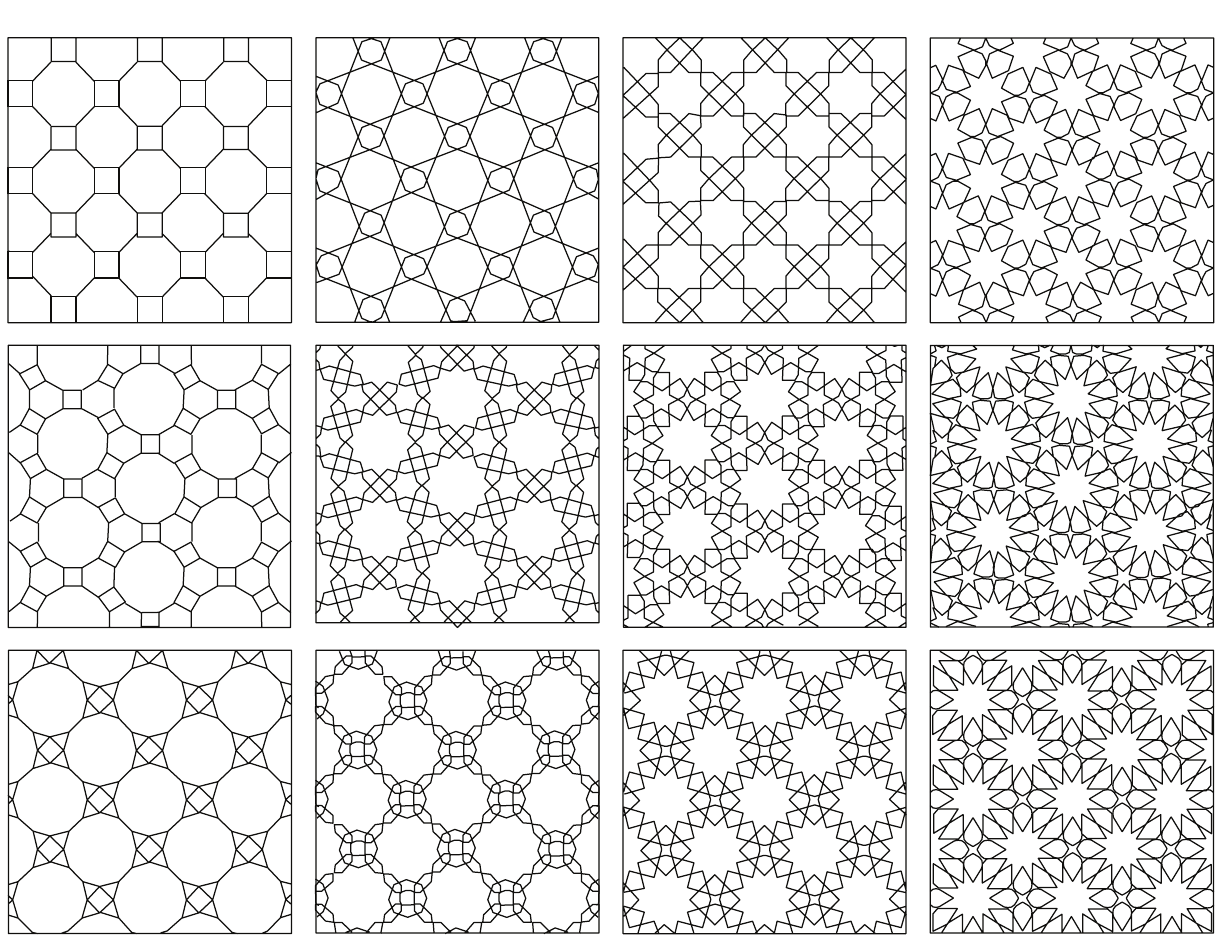
Figure 8: Variations of patterns using Hankin’s method (Craig S. Kaplan).